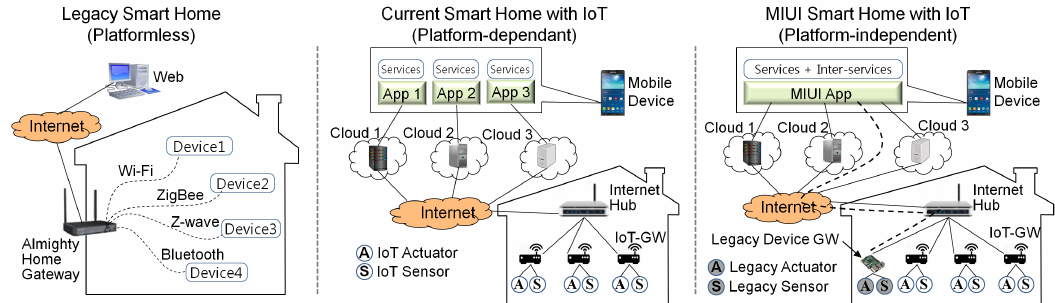
Figure 1. Evolution of smart homes in three phases. System architecture for the mobile-driven interoperation and user- attached interactivity